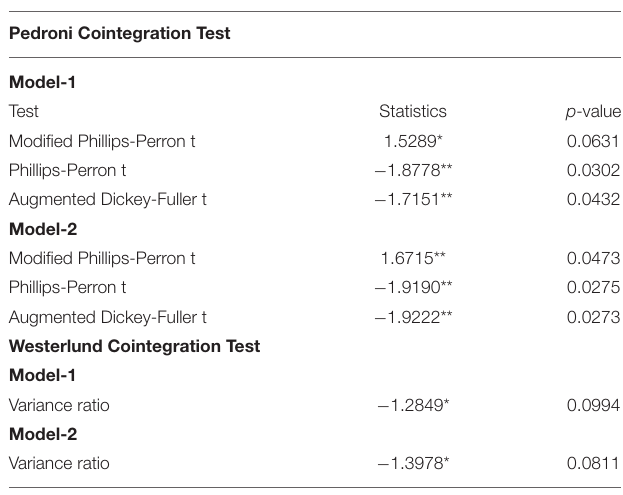
TABLE 7 | Cointegration